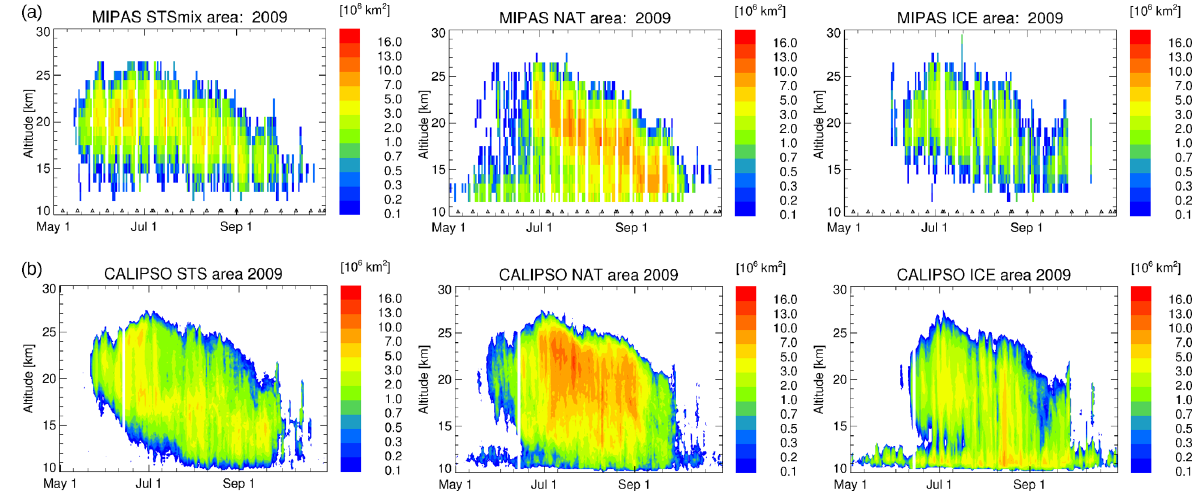
Figure 5. PSC type classification comparison between the MIPAS (Bayesian classifier version 1.2.8) row (a) and CALIOP (V2) row (b) based on the identical computation of A PSC for each dataset. For better comparability, MIPAS observations are restricted to latitudes < 82 ◦ S, the latitude coverage of CALIOP. Black triangles at 10.5km altitude in the MIPAS time series highlight data gaps usually caused by the mesosphere/thermosphere measurement mode.